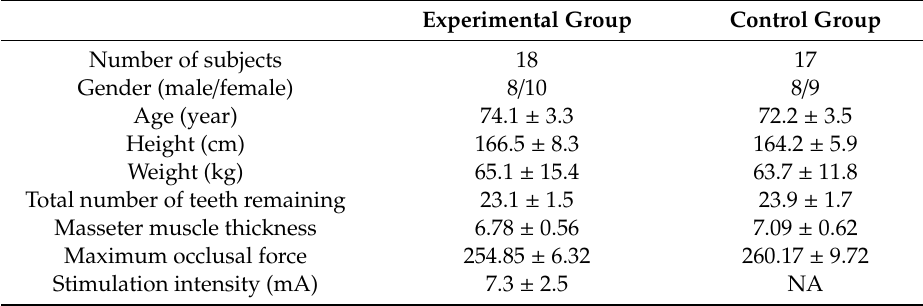
Table 2. A summary of the clinical and demographic features of the